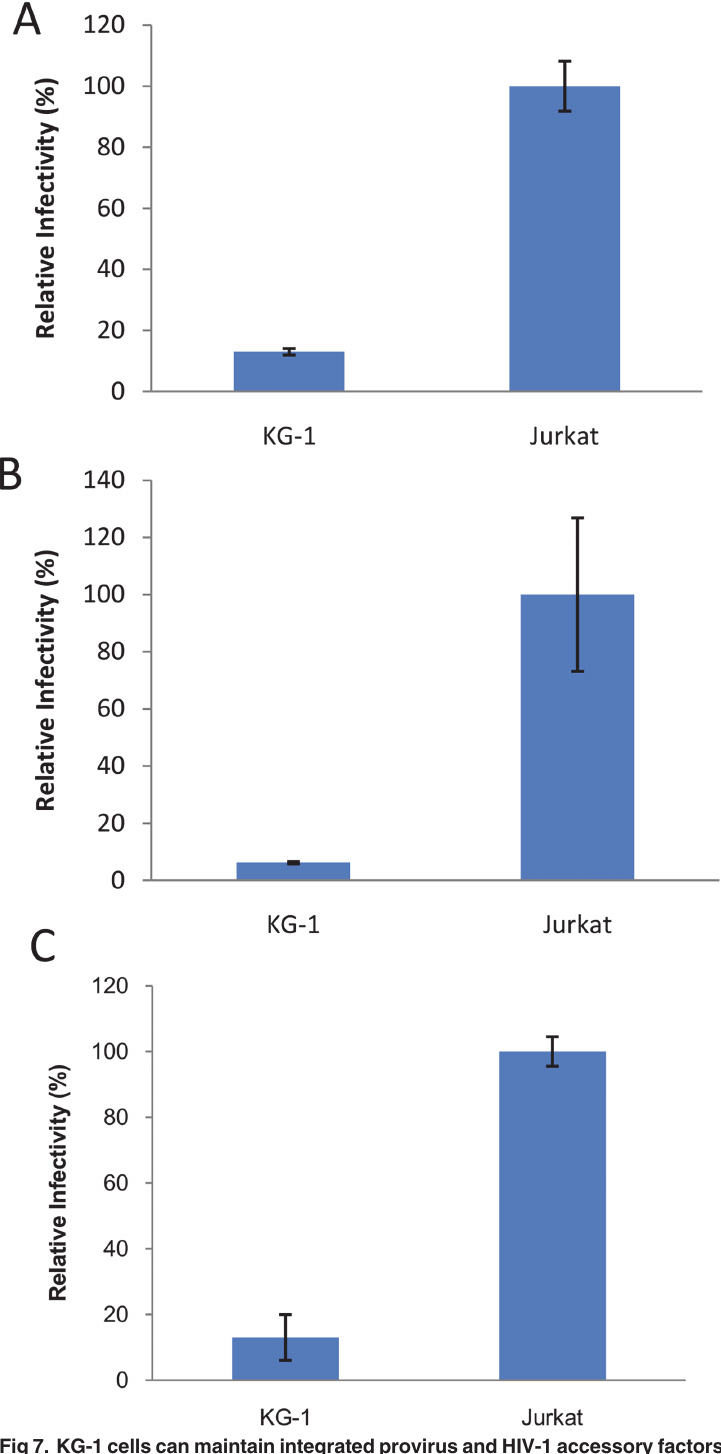
Fig 7. KG-1 cells can maintain integrated provirus and HIV-1 accessory factors doesn't rescue the block to infection. (A) KG-1 and Jurkat cells were infected with 4070A pseudotyped HIV-GFP at an MOI of 0.5. Percentage of EGFP positive cells were determined 4 weeks post infection. ( B) KG-1 and Jurkat cells were infected with 4070A pseudotyped MLV-GFP at an MOI of 1. Percentage of EGFP positive cells were determined 4 weeks post infection. ( C) KG-1 and Jurkat cells were infected with 4070A pseudotyped HIV-EGFP containing all HIV-1 accessory factors (HIG vector). Percentage of EGFP positive cells